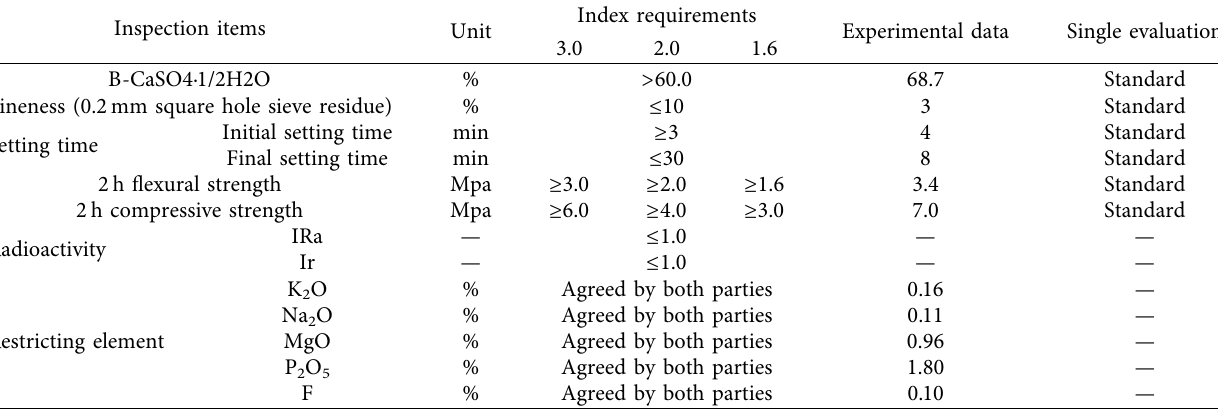
Table 3: Modified phosphogypsum powder (CaSO4 · 1/2H2O) properties.